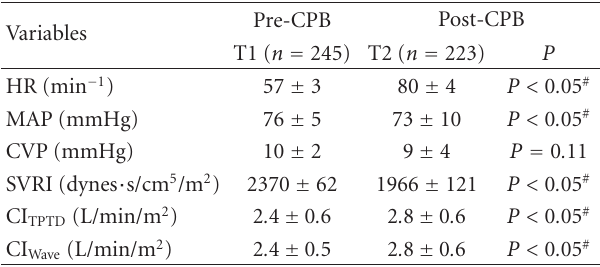
Table 1: Haemodynamic variables before (T1) and after (T2) cardiopulmonary